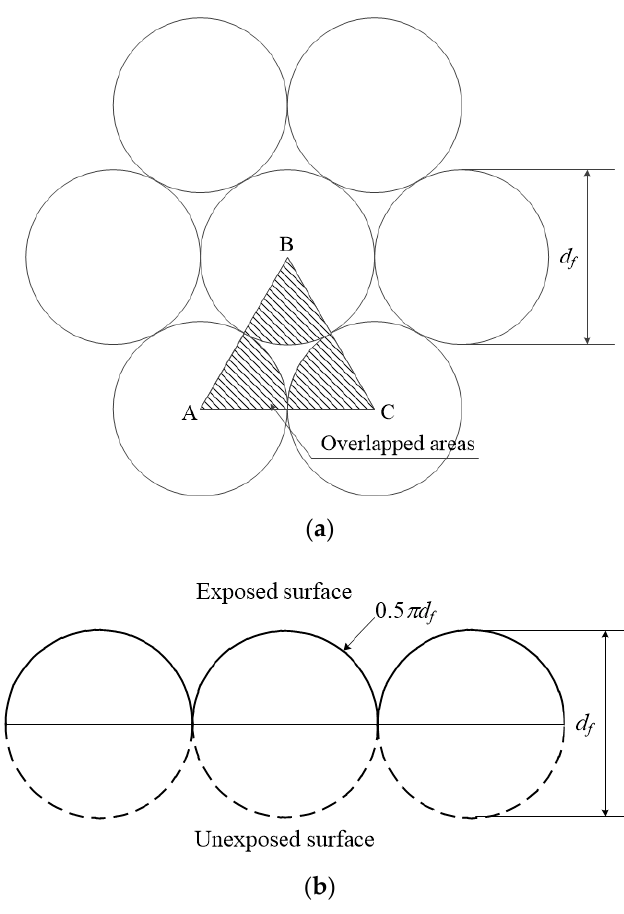
Figure 2. Exposed surface of a multifilament bundled fiber [27]: ( a ) Unit triangular element in a hexagonally packed bundle; ( b ) Surface roughness of a bundled fiber.